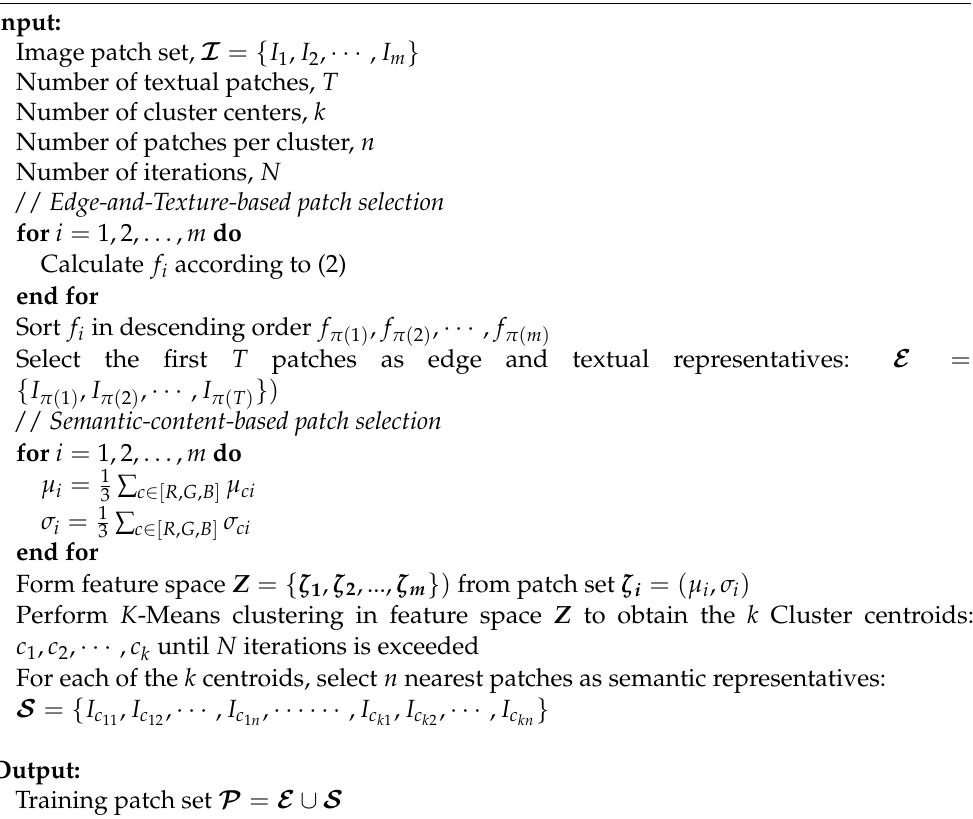
Algorithm 1 Multiple-Criteria-based Patch